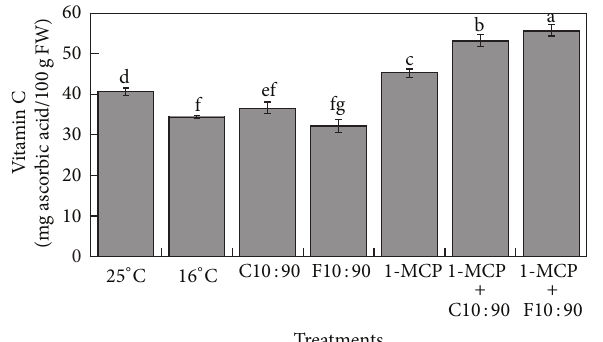
Figure 1: Vitamin C (mg ascorbic acid/100 g fresh weight of edible food) of seedless pulp obtained from soursop stored at 25 ∘ C, 16 ∘ C, fruits with emulsions and stored at 16 ∘ C; fruits treated with 1-MCP and stored at 16 ∘ C; fruits treated with 1-MCP + emulsions and stored at 16 ∘ C. Different letters indicate significant statistical differences between samples using the LSD test with 𝛼 = 0.05